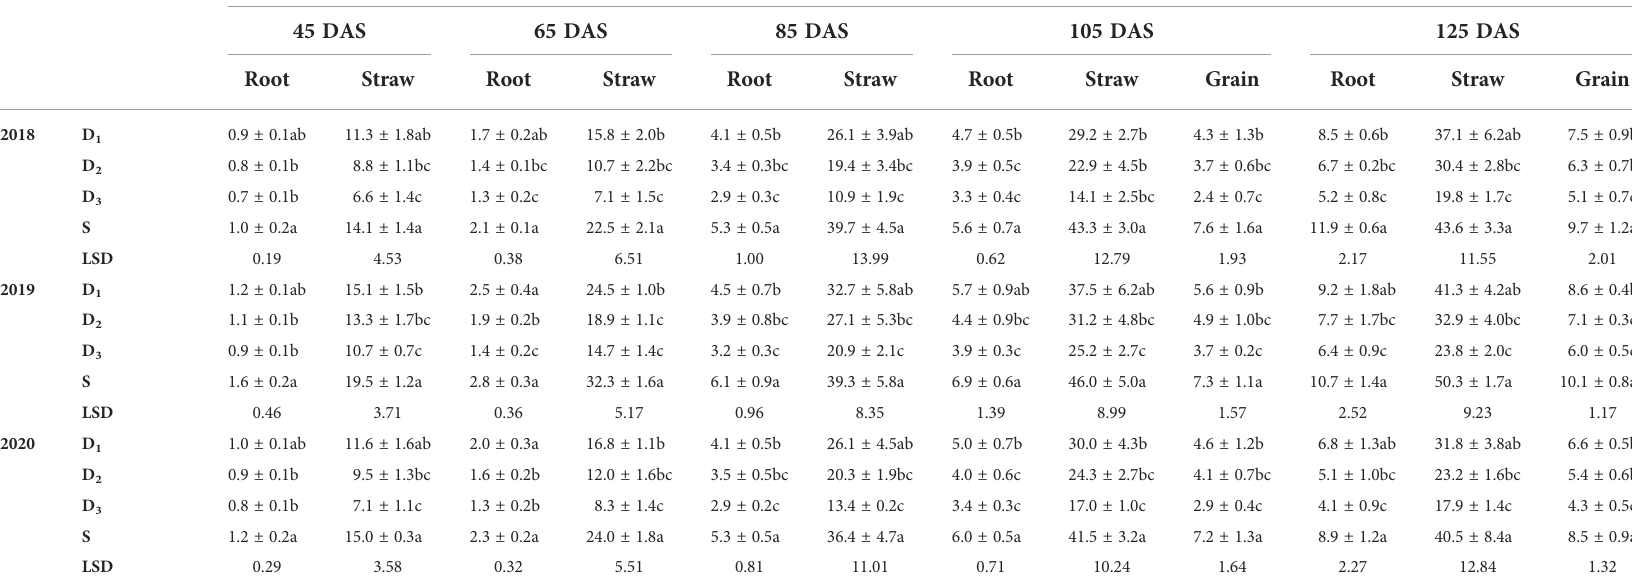
TABLE 5 Dry matter partitioning in different plant parts of soybean at 45, 65, 85, 105, and 125 days after sowing (DAS) under different maize/soybean strip intercropping treatments and sole cropping of soybean.